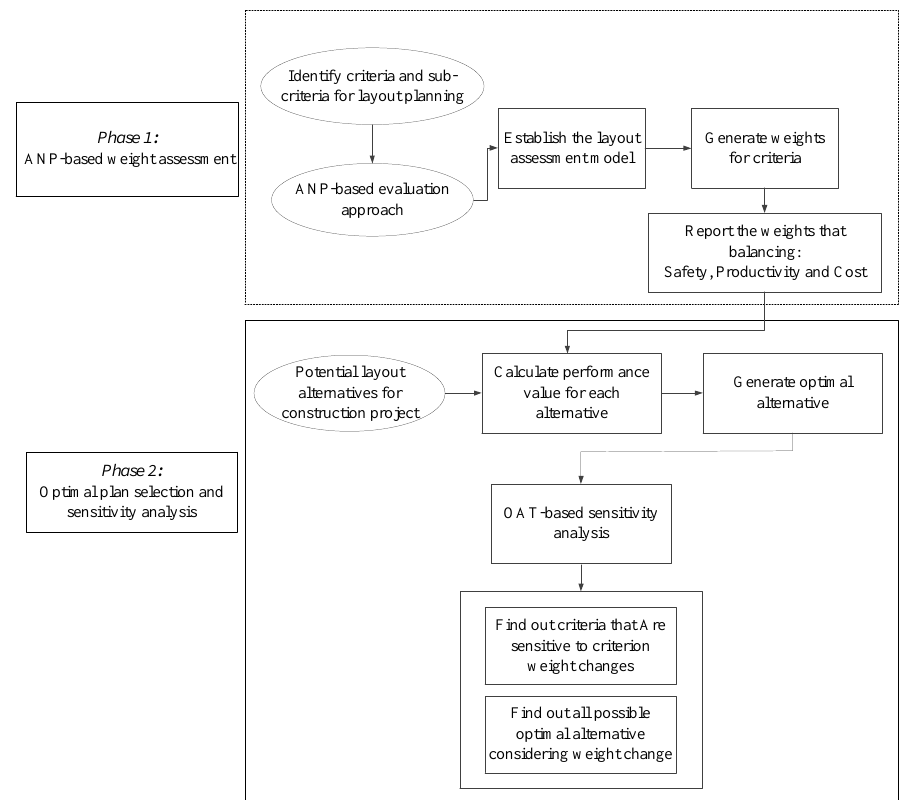
Figure 1. Overview flowchart depicting model development.